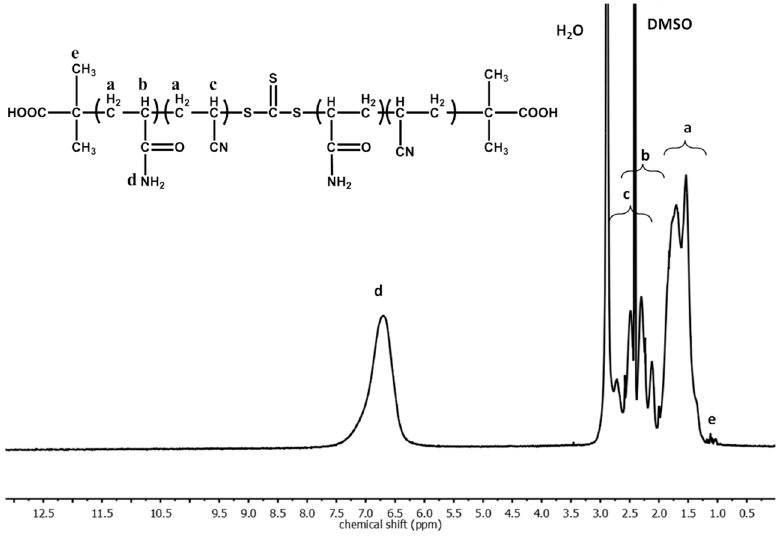
Figure 1. 1 H NMR Spectrum of the random copolymer P(AAm– co –AN) in d 6 -DMSO.